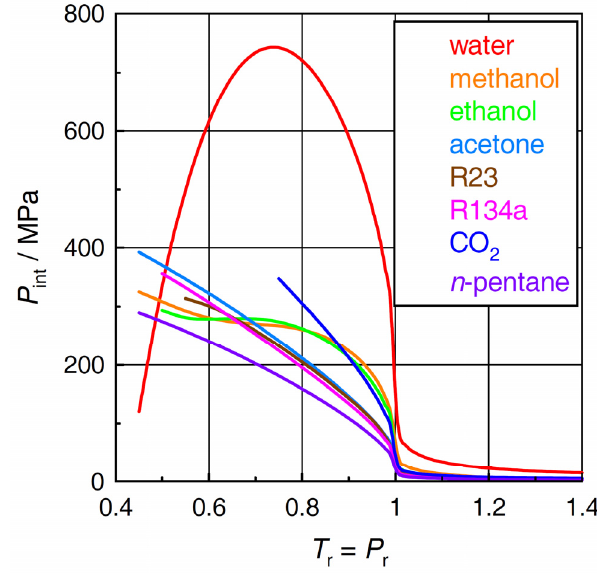
Figure 2. Internal pressures P int of the selected fluids.